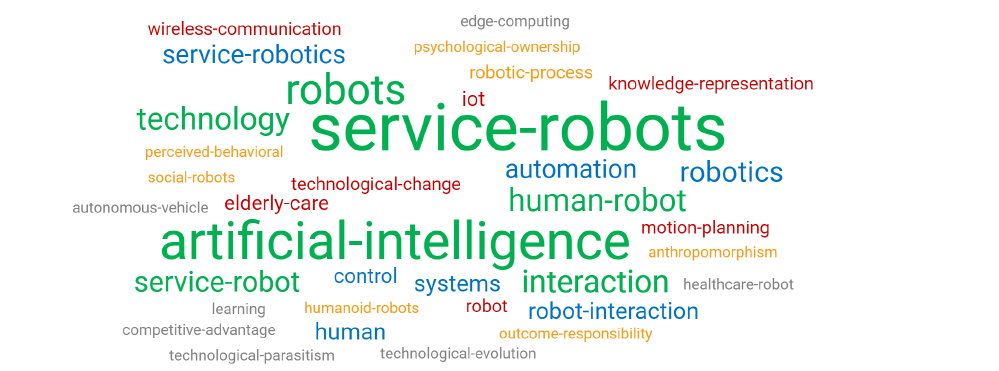
Figure 8. Word cloud of composite keywords used by authors in the reviewed